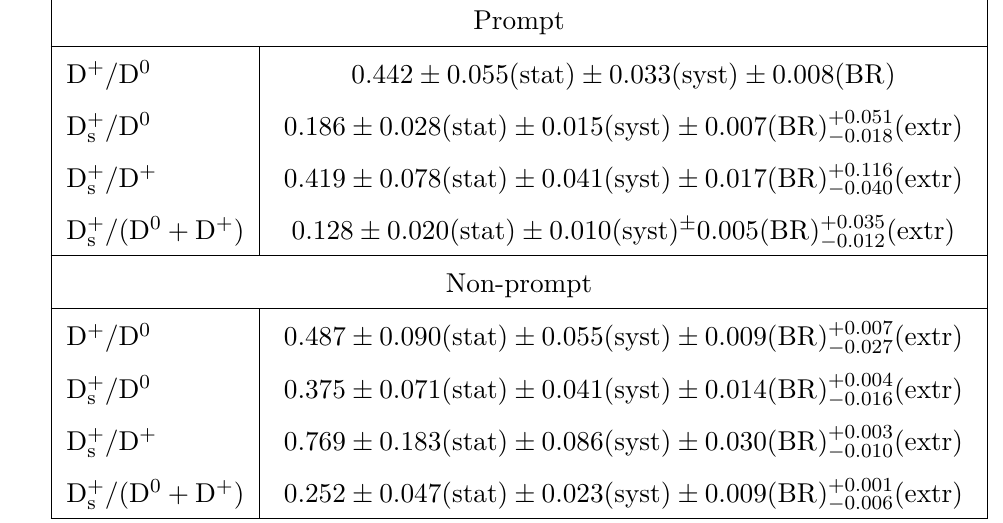
Table 5 . Ratios of the measured production cross sections of prompt and non-prompt D mesons in the range | y | < 0 . 5 in pp collisions at